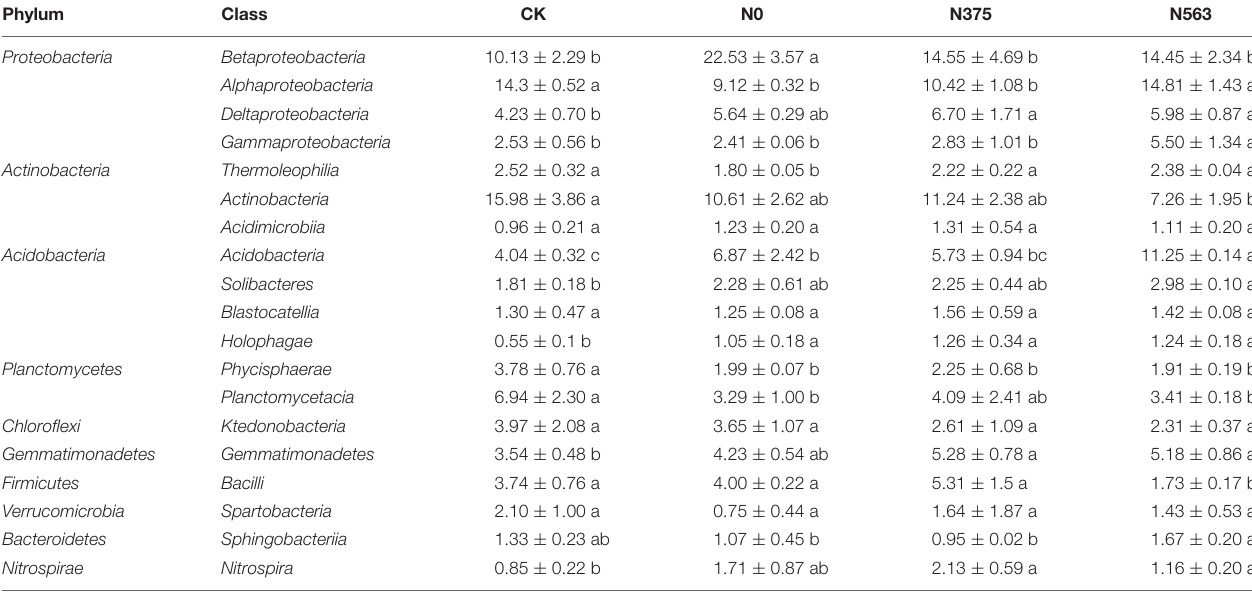
Values represent mean ± standard deviation of triplicate measurements. Values within the same row followed by different lowercase letters indicated significant differences (P < 0.05) according to Duncan’s multiple comparison tests. CK, without fertilization; N0, without N fertilization; N375, application of 375 kg/ha N; N563, application of 563 kg/ha N. TABLE 4 | Relative abundance (%) of the functional genera groups in all treatments.